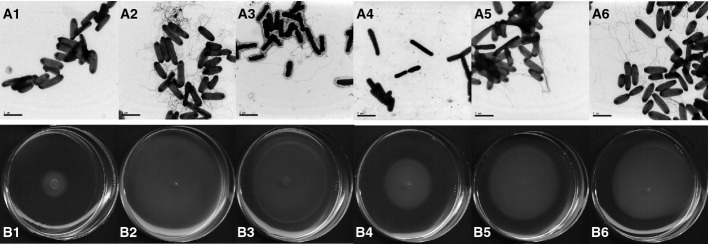
Physiological effects of the inactivation of RcsB due to the acetylation of lysine 154 in
E. coliA, B Presence of flagella (A) and mobility assays in semisolid agar (B) of the E.
coli wild-type strain (1) and mutants ΔcobB (2),
ΔrcsB (3), ΔrcsB+prcsB-K154R
(4), ΔrcsB+prcsB-K154Q (5) and
ΔrcsB+prcsB-K154E (6) was assessed. For both assays,
E. coli wild-type and its mutants were harvested at the exponential phase of
cultures.